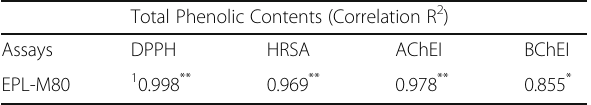
Table 3 Correlation coefficients between the total phenolic contents and antioxidant as well as cholinesterase inhibitory activity of